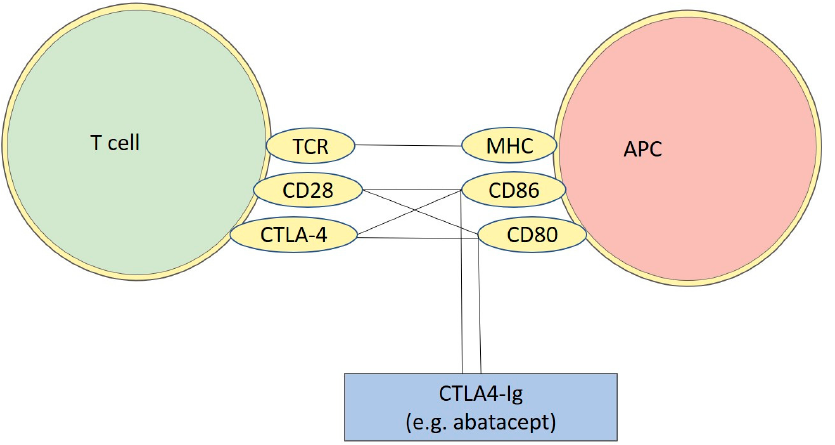
Figure 1. Schematic figure representing the binding sites of CTLA4-Ig. As illustrated, Cytotoxic T-Lymphocyte Antigen 4 (CTLA-4) share with CD28, located on T-cells, the possibility of binding with CD86 and CD80, located on APC (antigen-presenting cell). Abatacept can be used as a possible treatment for multiple sclerosis (MS), since it binds to CD86 and CD80 in a similar way as CD28 and CTLA-4. This leads to a competition for the binding site, resulting in a blockage of T-cell maturation where the T-cell are unable to interact with APCTCR: T cell receptor; MHC: major histocompatibility complex.